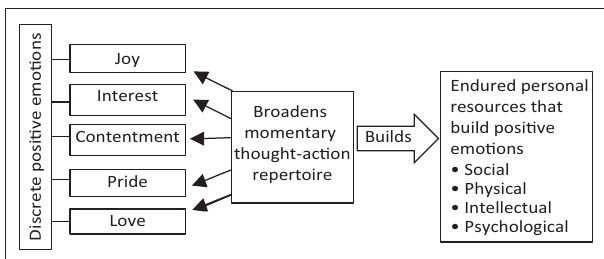
FIGURE 1: Model based on Fredrickson’s (2001) broaden-and-build